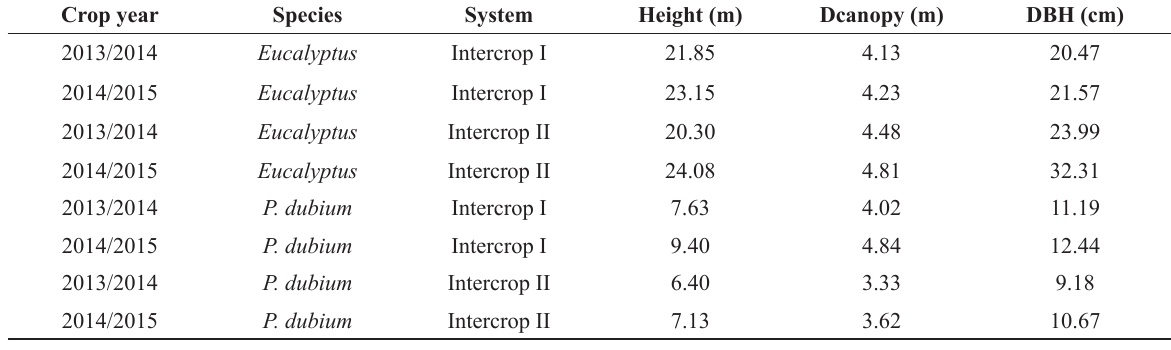
Height (H), mean diameter of canopy (Dcanopy) and diameter at breast height (DBH) of Eucalyptus and P. dubium in two crop years (2013/2014 and 2014/2015) and two Intercrop systems. Southern, Brazil.